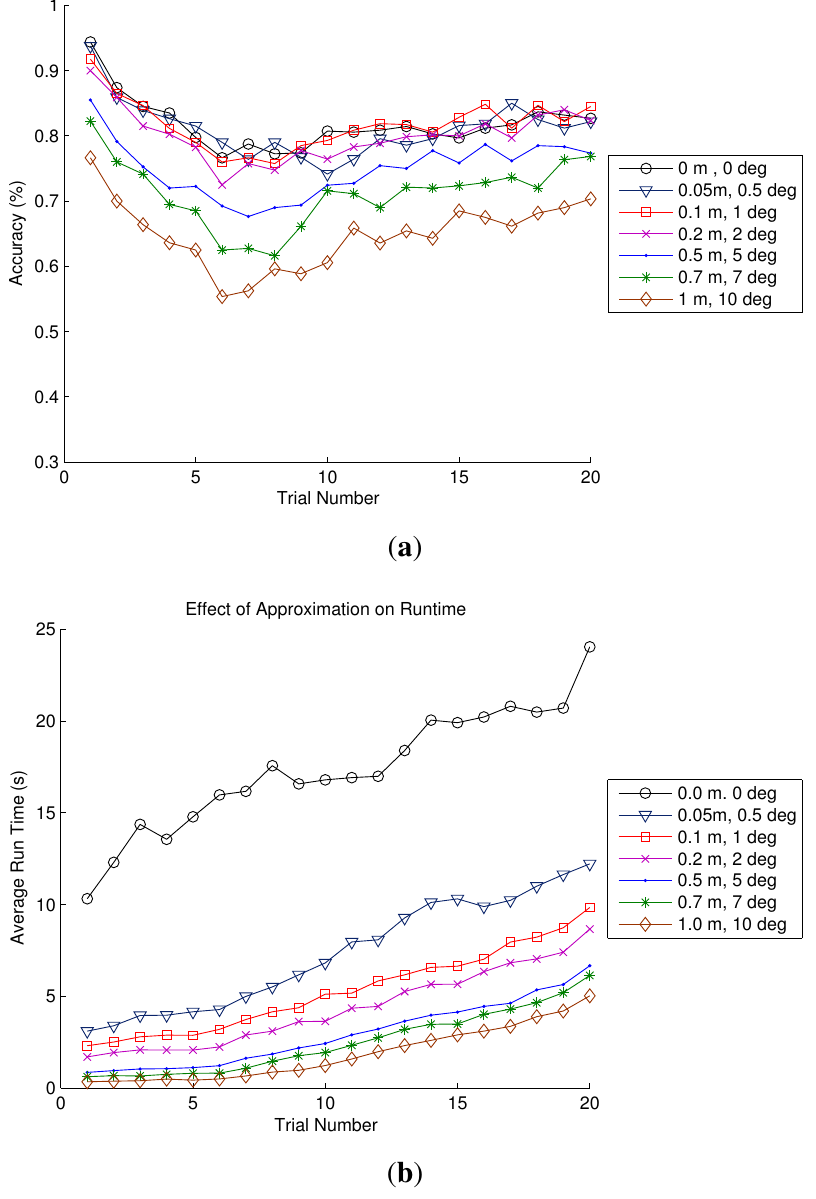
Figure 13. The effect of solution space discretization on the FGSM algorithm for increasing levels of error in initial condition. ( a ) Accuracy computed for different amounts of solution space discretization. ( b ) The average runtime of the FGSM algorithm for different levels of